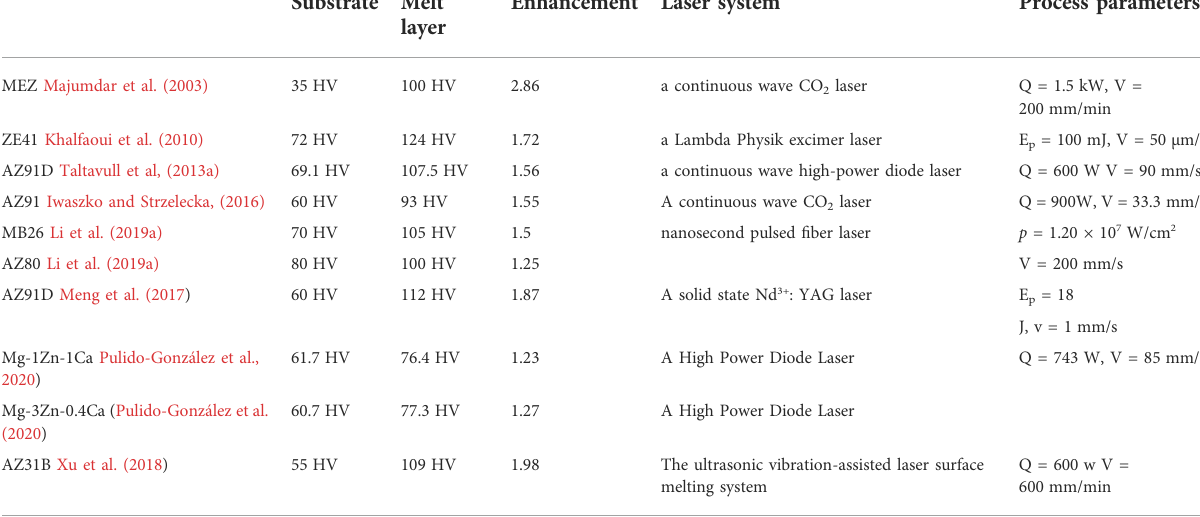
TABLE 2 The variation of hardness on the surface of laser-modi fi ed Mg alloys. Substrate Melt